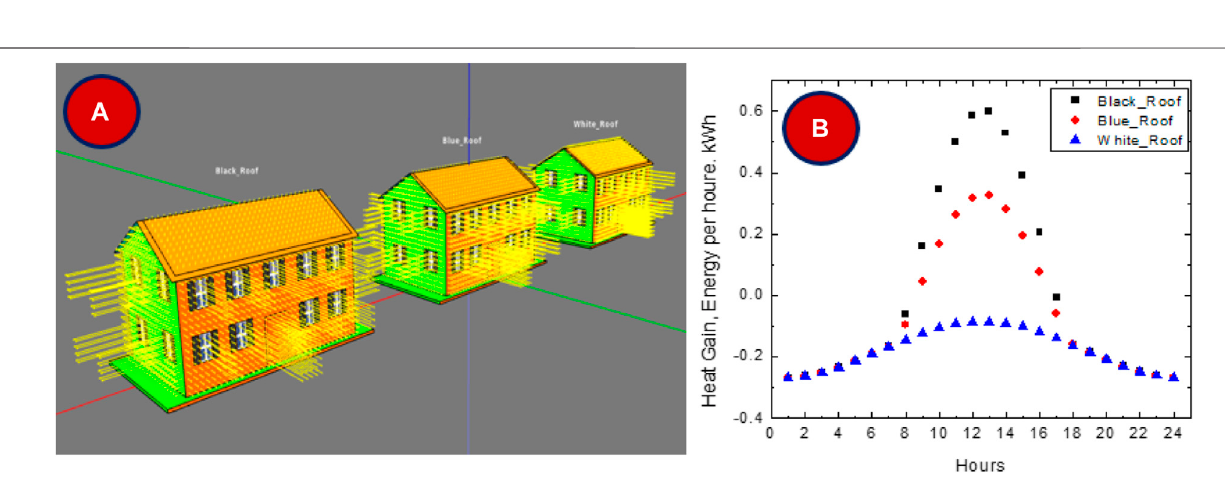
FIGURE 4 | Energy form of the three buildings (A) and energy loss rate of the three buildings during 10th of December (B) .